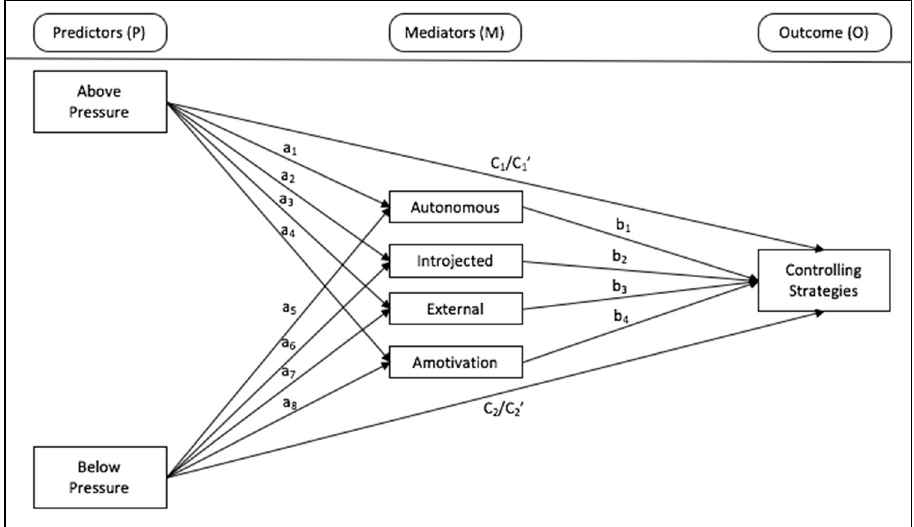
Figure 1. Hypothesized mediation model.